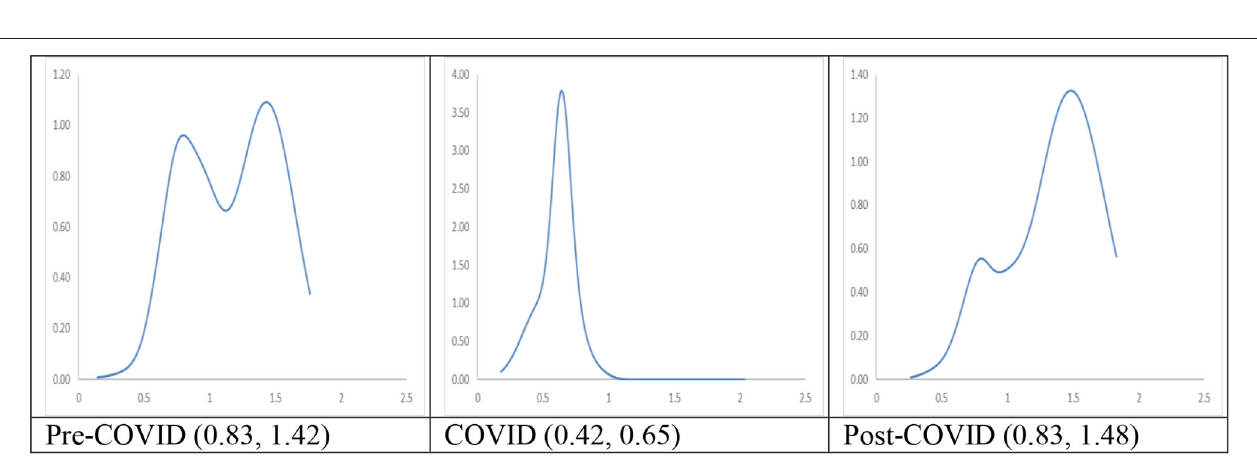
FIGURE 8 | Mobility probability plot (MPP) for the RDIPC of all residents in cities with the shortest duration of Level I ERS with quarterly transitions. Source: authors’ calculation. N.B. The vertical axis indicates net upward mobility (%) and the horizontal axis indicates RDIPC values.